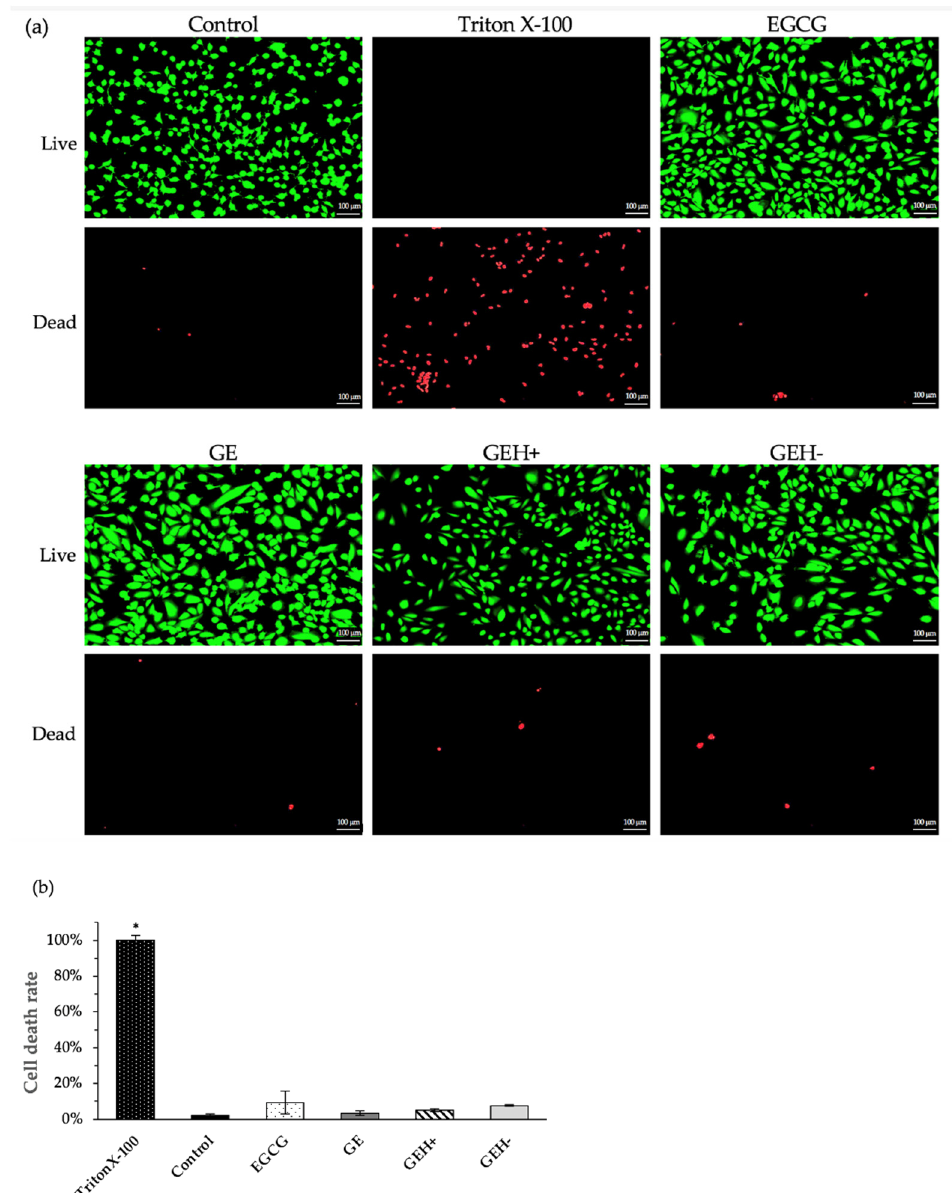
Figure 4. ( a ) Photos of live/dead cells staining of ARPE-19 cells when cultured with variant NP formulation at EGCG concentration of 20 µ g/mL for one day (scale bar: 100 µ m). ( b ) Image’s quantification of cell death rate (mean ± SD, n = 3), * p < 0.05 compared with control).